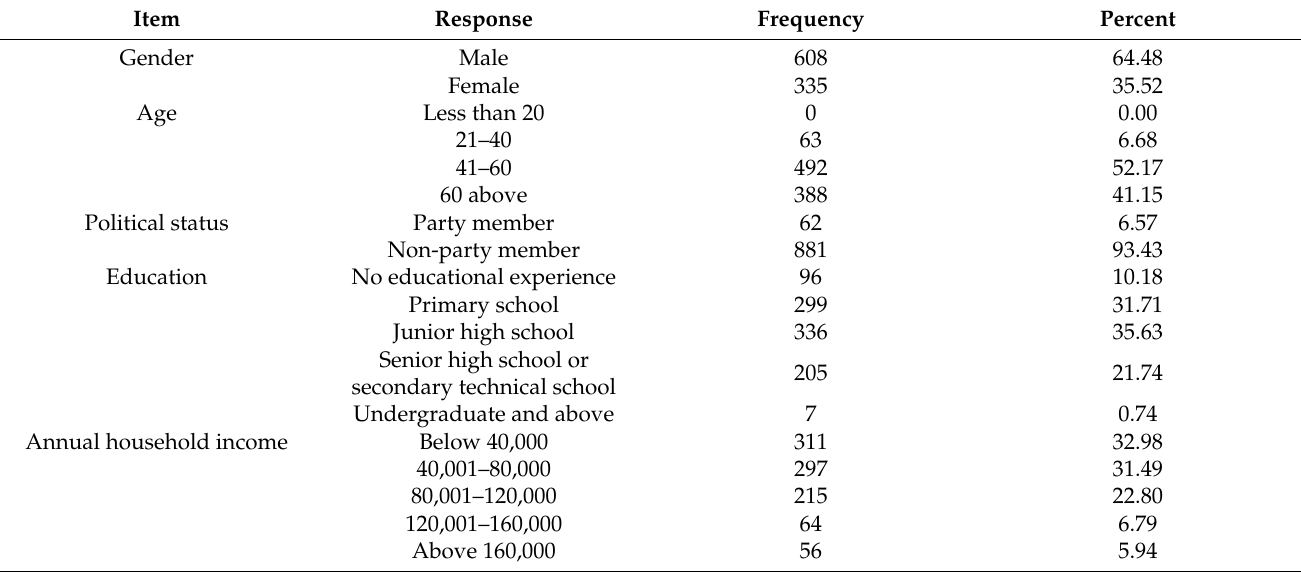
Table 2. Socio-economic characteristics of the respondents ( n =